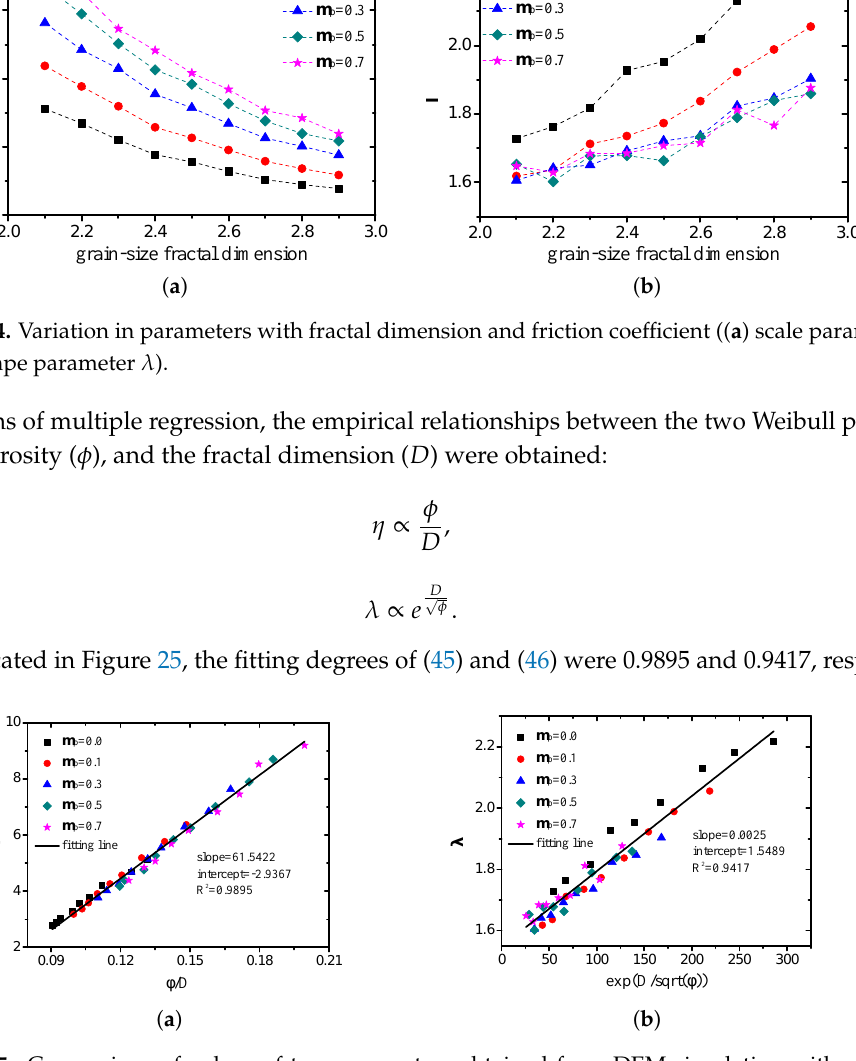
Figure 25. Comparison of values of two parameters obtained from DEM simulation with values calculated by two empirical relationships provided in this study (( a ) scale parameter η ; ( b ) shape parameter λ